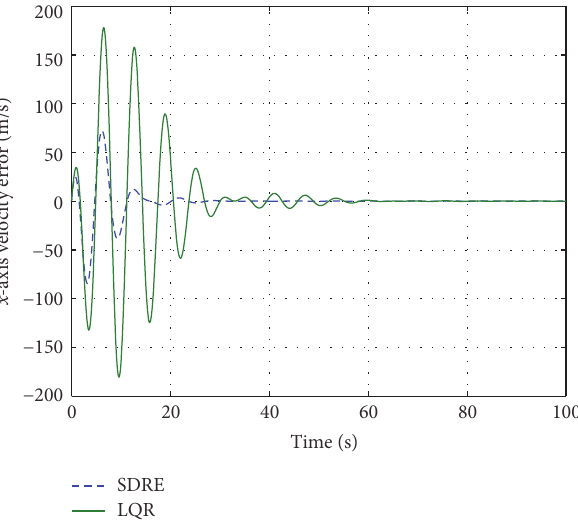
Figure 9: 𝑋 axis velocity error variation